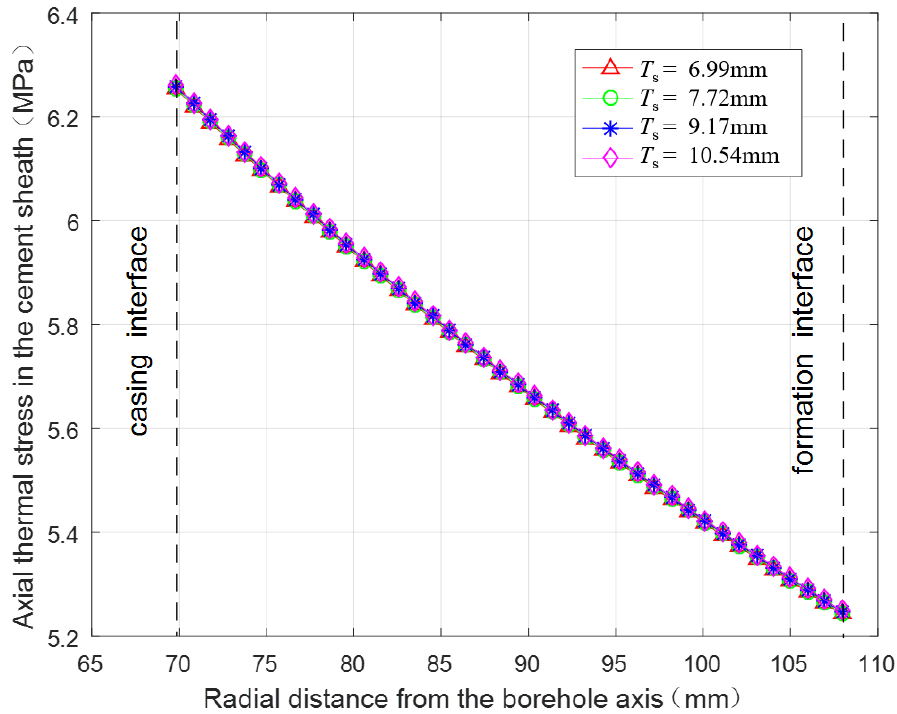
Figure 6. Radial distribution of the axial thermal stress in the cement sheath under different wall thicknesses of the casing.